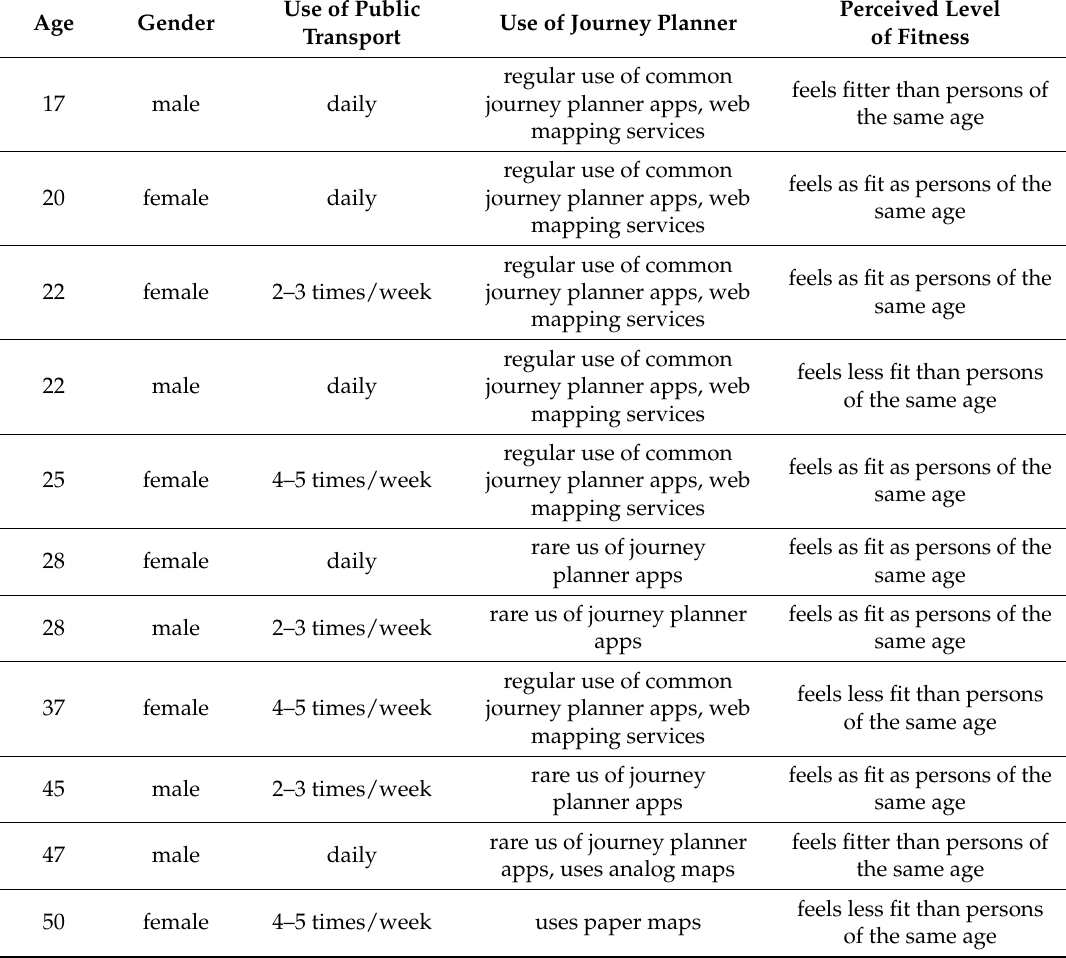
Table A2. Description of the sample of the participants of the focus group